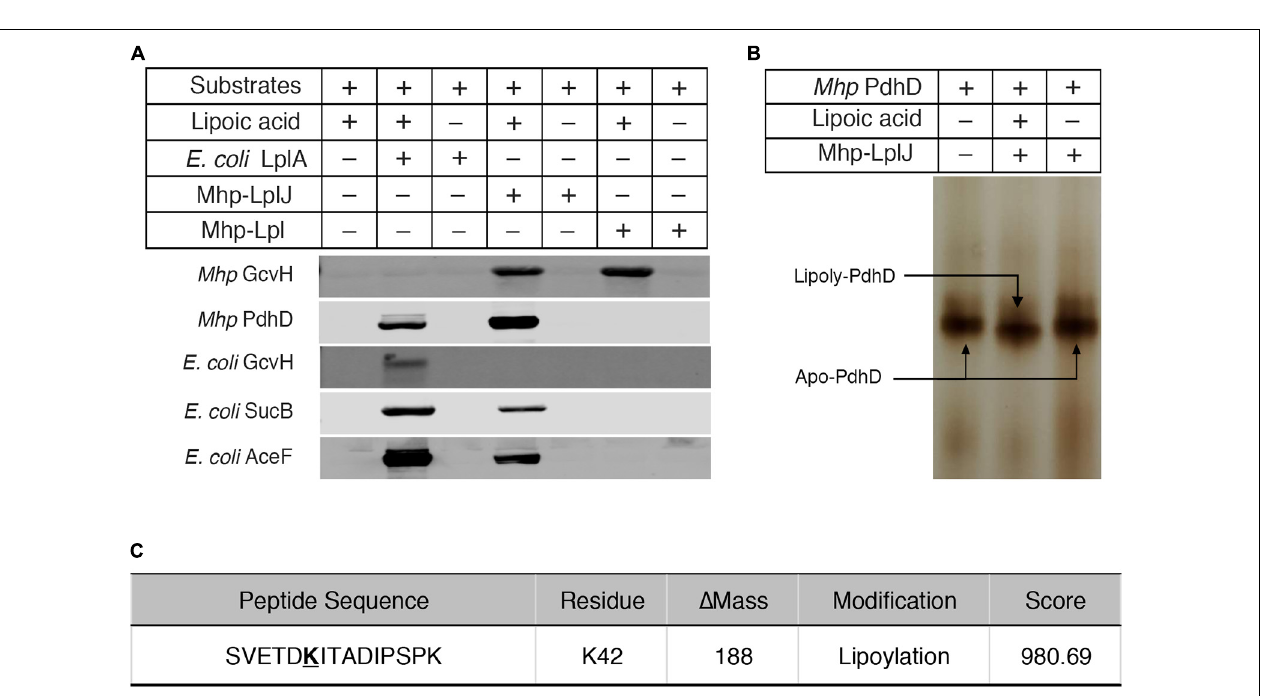
Frontiers in Microbiology |